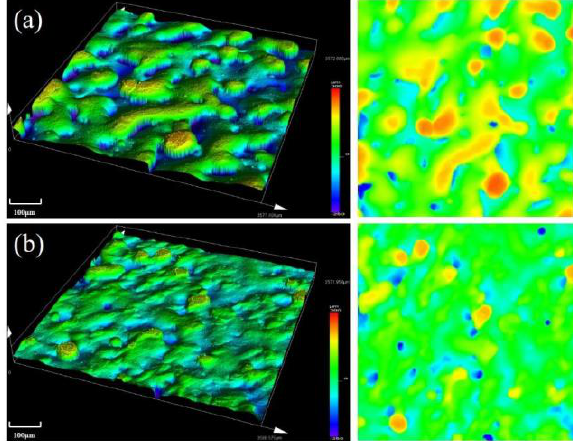
Figure 16. Surface topography of the SLM alloy formed at different hatching distances: ( a ) 0.08 mm and ( b ) 0.06 mm.